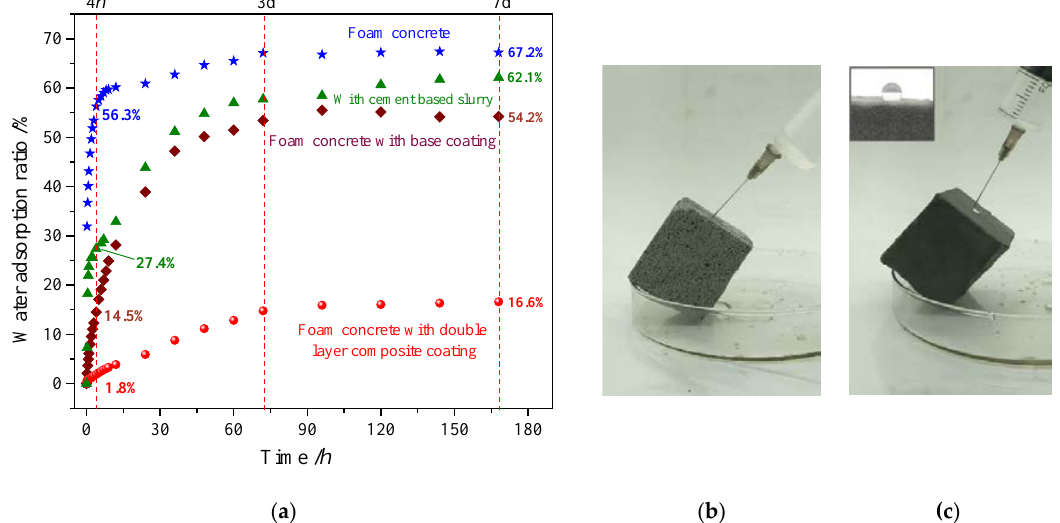
Figure 13. Waterproofness of different blocks: ( a ) Water adsorption ratio of different test blocks; ( b ) Water drop instantly seeps into foam concrete; ( c ) Water drop rolls off the concrete surface with superhydrophobic composite coating.